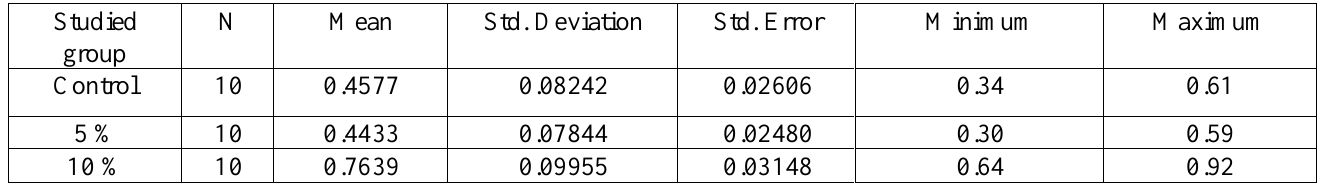
Table 6: Descriptive statistic of water sorption test (mg/cm 2 )